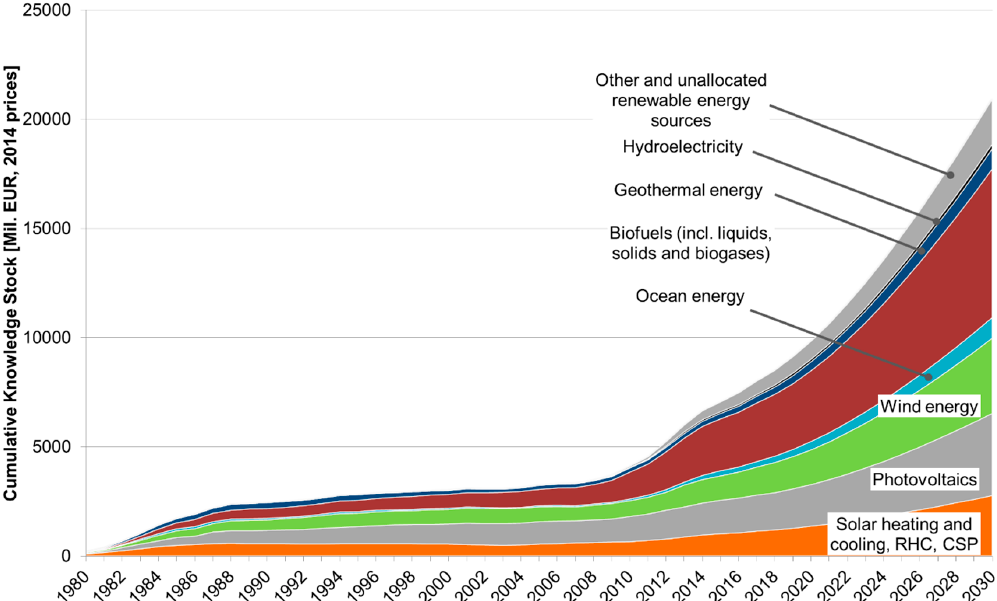
Figure 10. Cumulative RES knowledge stock induced by public R&D expenditures of the EU MS and the EC (Mil. EUR, Advanced scenario) (2014 prices and exc. rates; knowledge depreciation, 10%; time lag, three years).